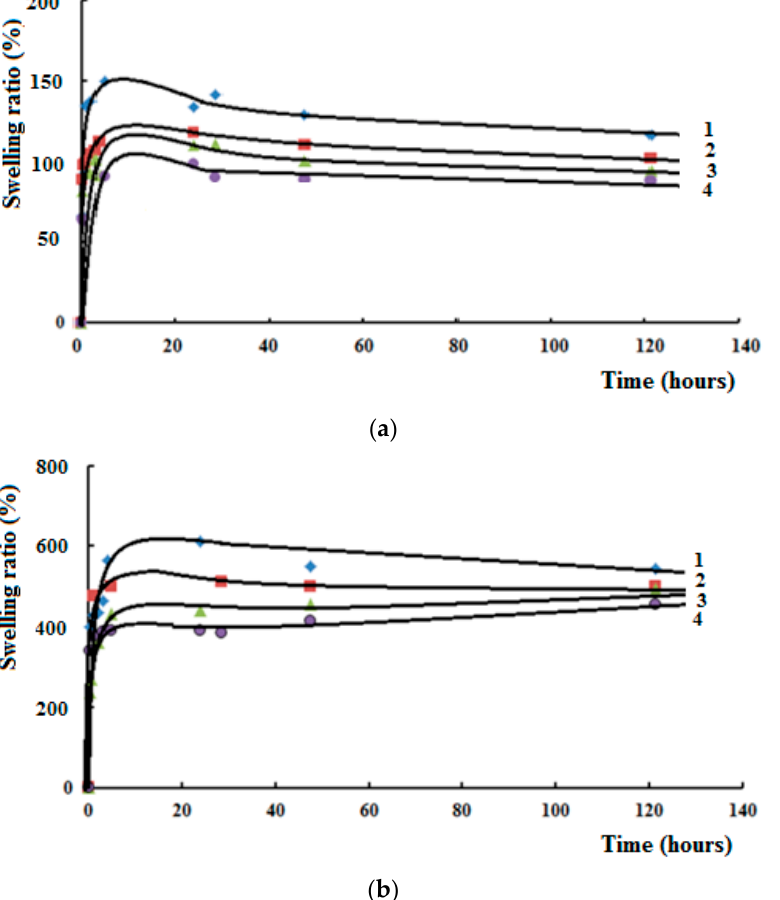
Figure 8. Swelling kinetics of hydrogels on the base of hydrochloride chitosan and citrus ( a ) or apple ( b ) pectin in distilled water (1), NaCl solution of different concentrations: 0.5 % (2), 0.9% (3), 2.0% (4). Data are expressed as mean ± SD; n = 3.